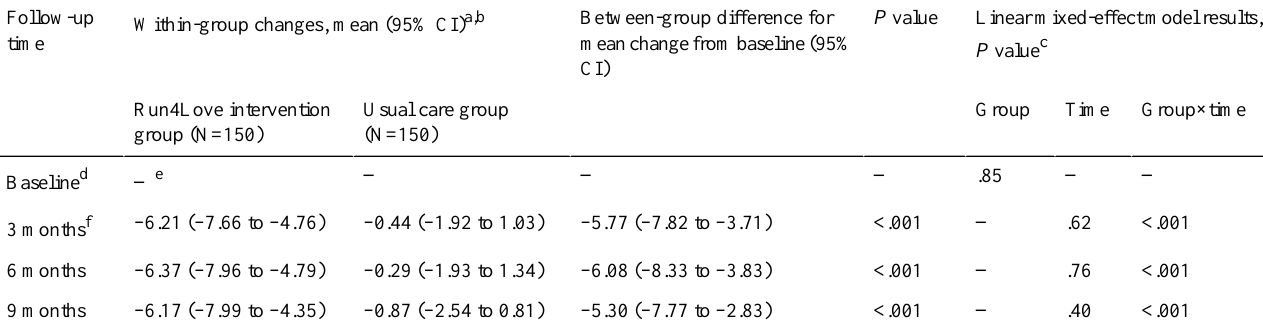
Table 2. Effects of the intervention on primary outcome (Centre for Epidemiological Studies Depression score).